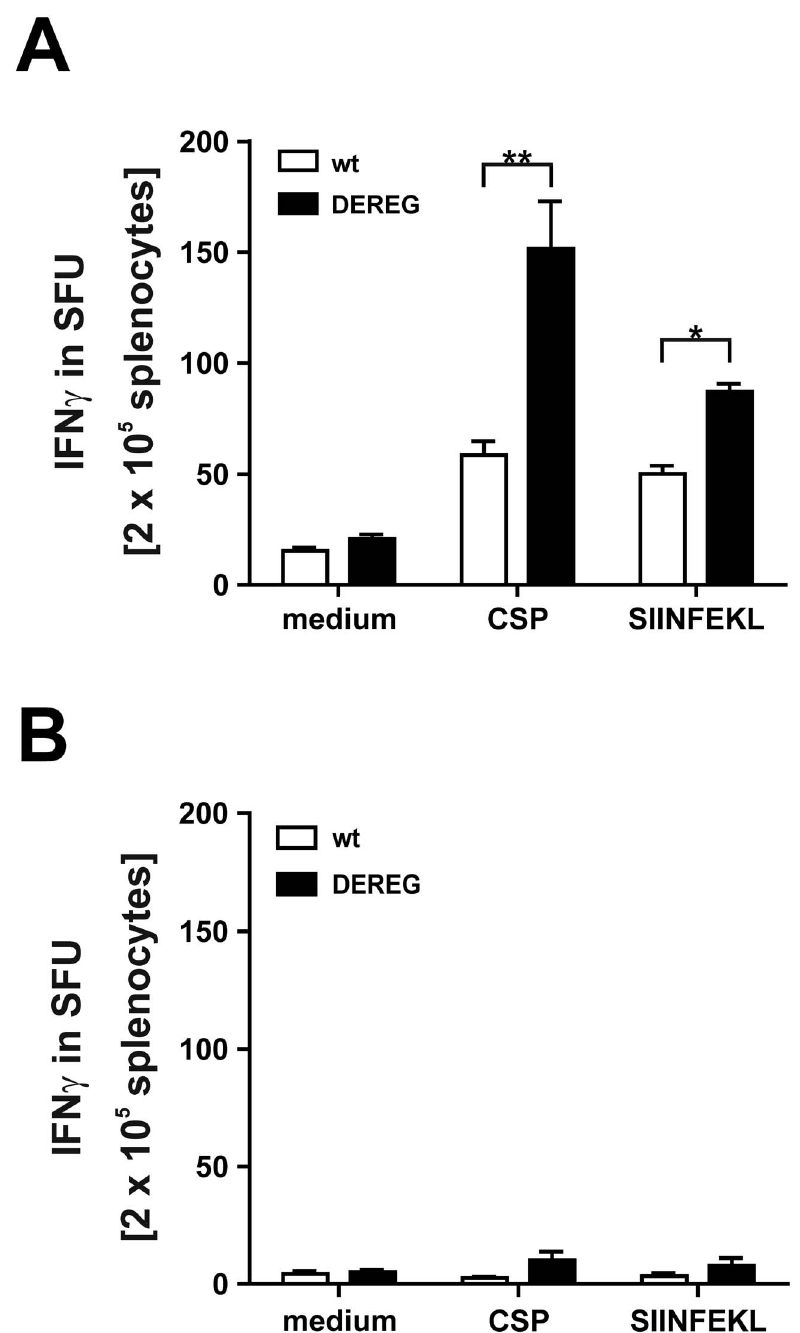
Figure 6. Effect of T reg -depletion on the efficacy of a boost immunization. (A) To analyze the effect of T reg depletion on the efficacy of a boost immunization, we vaccinated F1 DEREG mice or their non-transgenic littermates with ACT-CSP on day 0 and day 14. Both groups of mice were treated on days 15, 16 and 17 with DT. On day + 25, spleen cells were restimulated with CSP-peptide or OVA-peptide and IFN c production in spot forming units (SFU) was analyzed using ELISPOT. Data are expressed as mean + / 2 SD of 5 mice. This experiment was repeated twice with similar results. *, p , 0.05, p , 0.01. (B) A similar experiment was performed using as well F1 DEREG mice and F1 non-transgenic littermates that were treated on days 15, 16 and 17with DT but without previous